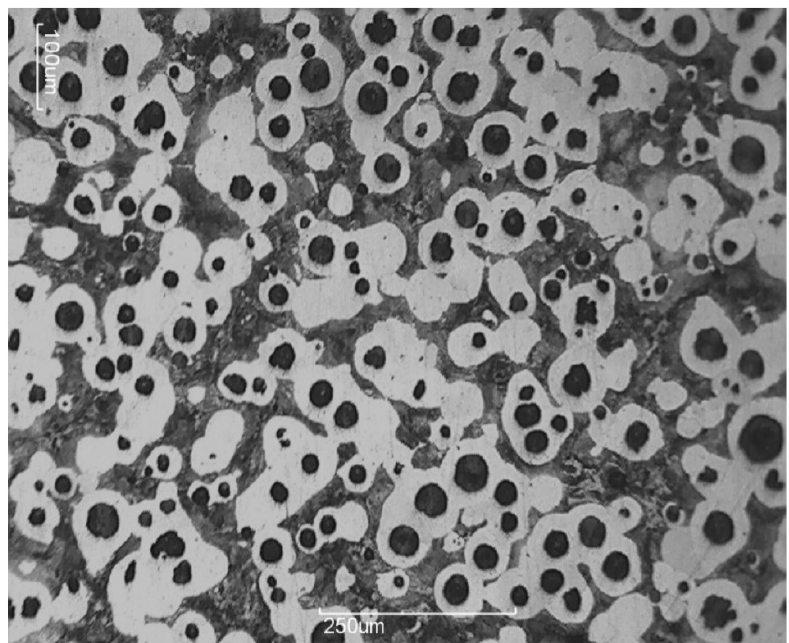
Figure 12. Micrograph of the central section of the specimen (100×).